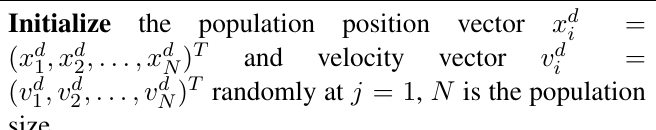
Table 2. Pseudo code of the PSO